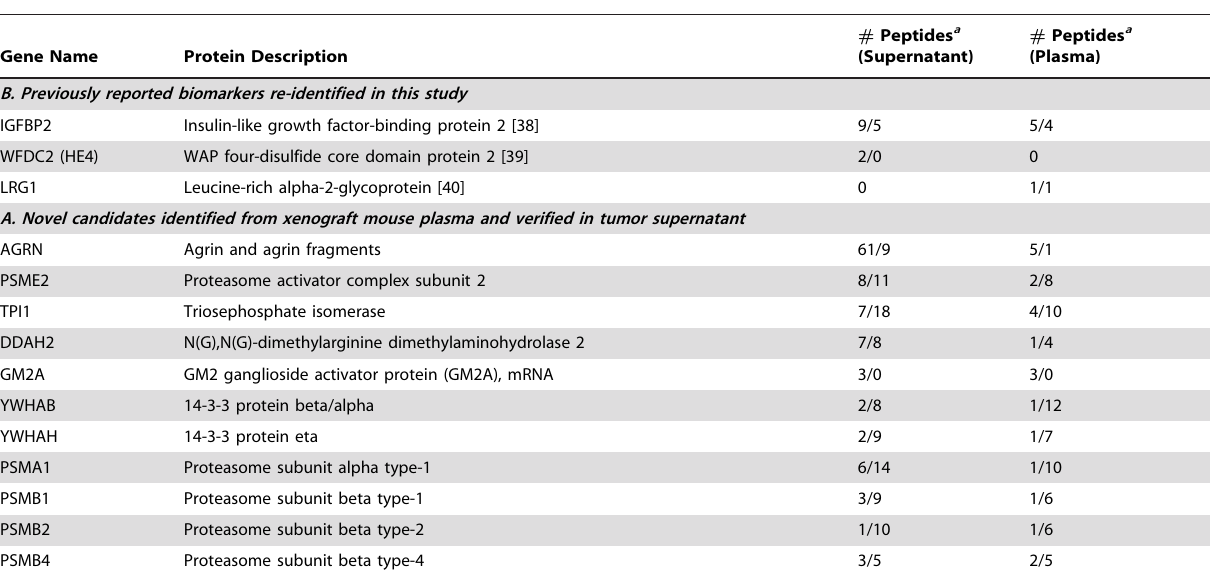
Table 1. Candidate biomarkers for validation in patient serum